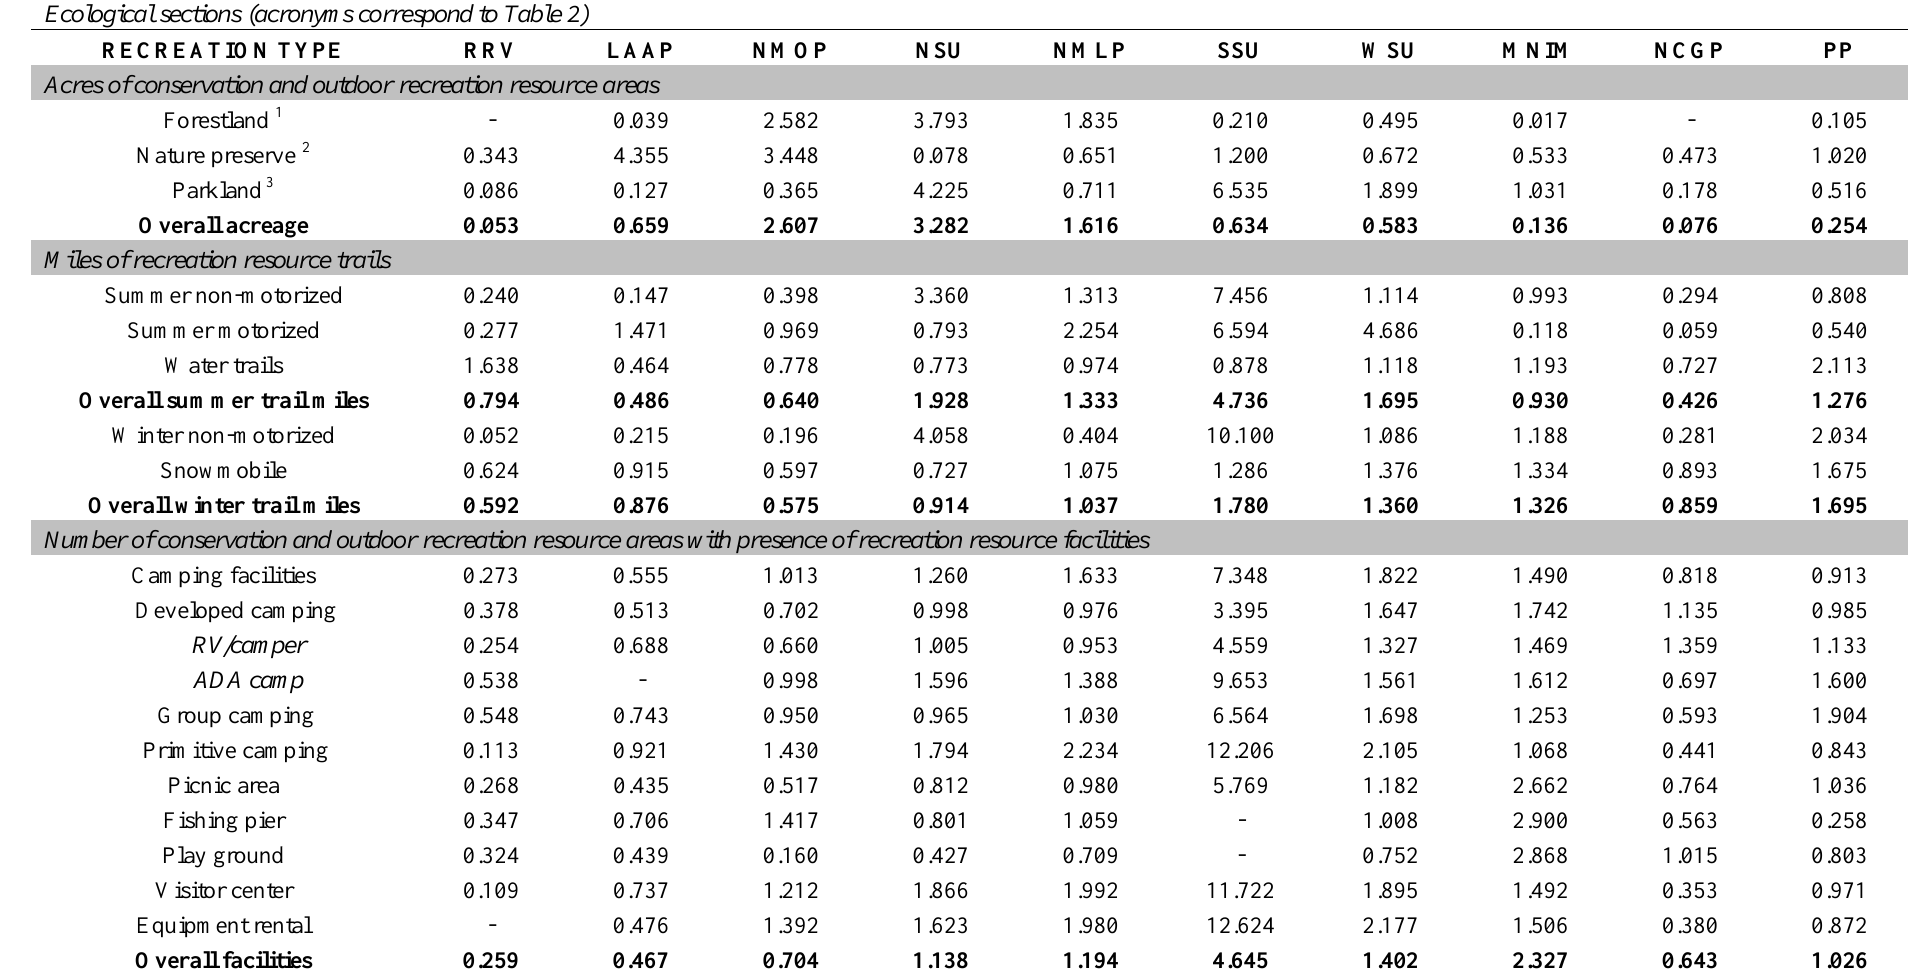
Table 4. Area-based recreation location quotients by ecological section. Ecological sections (acronyms correspond to Table